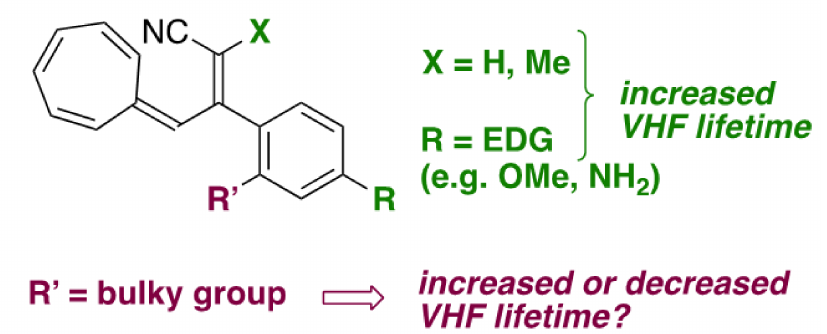
Figure 2. Introducing a hydrogen atom or methyl at the vinylic position of VHF (corresponding to position C-1 of DHA) or introducing an electron-donating group (EDG) at the para position of the phenyl enhances the VHF lifetime. Here, we investigate the influence of bulky groups at the ortho position of the phenyl